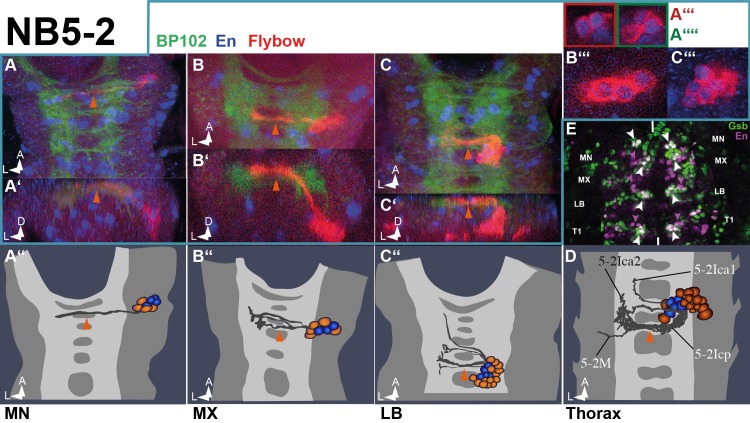
NB5-2 lineage in gnathal segments.(A–D) Frontal (A´, B´, C´, A´´´´) and horizontal (all other) views of NB5-2 clones (semischematic drawings in A´´, B´´, C´´ and D and composed confocal stacks in all other images). In abdominal and thoracic segments (D) NB5-2 generates a large clone with more than 20 cells that lie in a ventral and medial position. It is one of the few clones that send projections via both segmental commissures (see also MX and LB). In MN the cells of the NB5-2 lineage lie ventrally at the anterior border of the VNC sending a single projection through the commissure dorsally (A and A´) similar to 5-2Icp (red arrowheads in A–D). As we used Engrailed (En) as an obligatory landmark staining we noticed that 3 to 5 NB5-2 progeny cells express En at late stages (blue cells in A´´-C´´, A´´´-C´´´ and D). (E) The En-positive NB5-2 cells are the only ventral cells that strongly co-express Gooseberry (Gsb) (white arrowheads). Note the pair of NB4-1 En-positive cells (magenta arrowheads) that lie antero-laterally to the NB5-2 cells in MX, LB and T1 (NB4-1 not present in MN).